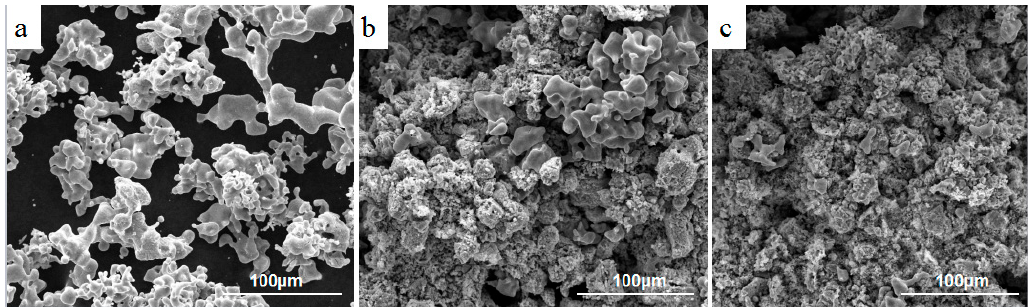
Figure 8. Leaching samples with different content of CaCl 2 in raw material: ( a ) Ti 2 O 3 /CaCl 2 (wt.%) = 2:1; ( b ) Ti 2 O 3 /CaCl 2 (wt.%) = 4:1; ( c ) Ti 2 O 3 /CaCl 2 (wt.%) = 6:1.